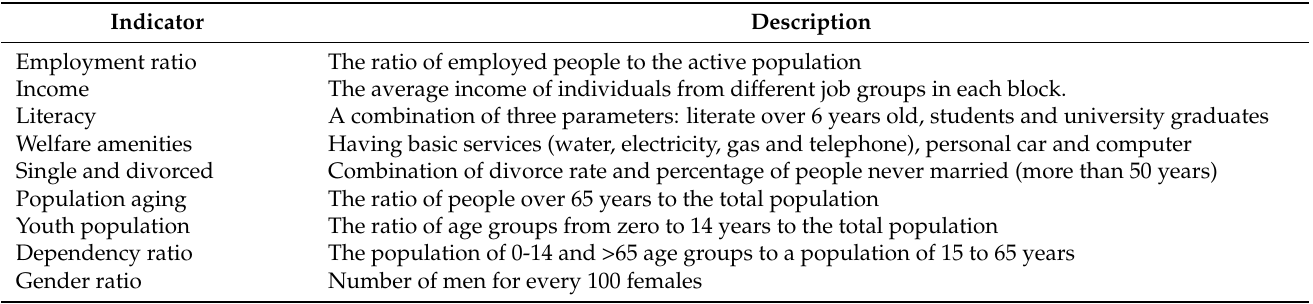
Table 3. The most important geodemographic indicators used for testing of the proposed methodology. Indicator